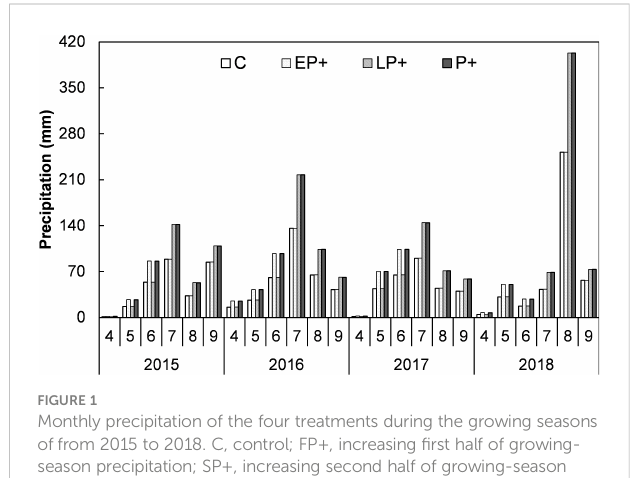
FIGURE 1 Monthly precipitation of the four treatments during the growing seasons of from 2015 to 2018. C, control; FP+, increasing fi rst half of growing- season precipitation; SP+, increasing second half of growing-season precipitation; P+, increasing entire growing-season